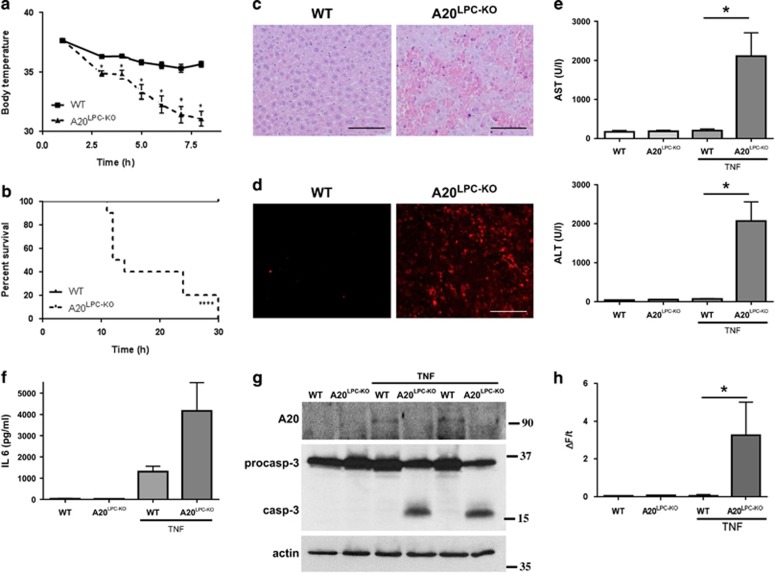
A20 protects hepatocytes from apoptosis in experimental hepatitis. (a-b) Body temperature (a) and survival (b) of A20LPC-KO mice (n=10) and control (WT; n=10) littermates after i.p. injection of 10 μg mTNF. *,P<0.05; ****,P<0.0001 versus control. (c) Hematoxylin and eosin (H/E) staining on liver sections from A20LPC-KO and control WT littermate mice injected with TNF for 5 h. (d) TUNEL staining on liver sections from A20LPC-KO and wild-type (WT) mice 5 h after mouse TNF injection, staining apoptotic cells in red. Scale bar=100μm. (e) Serum ALT and AST levels of A20LPC-KO mice (n=7) and control (WT; n=9) mice 5 h after mTNF injection. (f) Serum IL6 levels of A20LPC-KO mice (n=2) and control (WT; n=3) mice 5 h after mTNF injection. (g) Western blot analysis of A20, caspase-3 and actin expression in liver tissue from A20LPC-KO mice and control littermate mice (WT) either or not injected with 10 μg mouse TNF for 5 h. Westerns blots are representative of two independent experiments. (h) Caspase activity assayed on liver tissue homogenates of A20LPC-KO mice and WT littermates either or not injected with TNF for 5 h. *,P<0.05